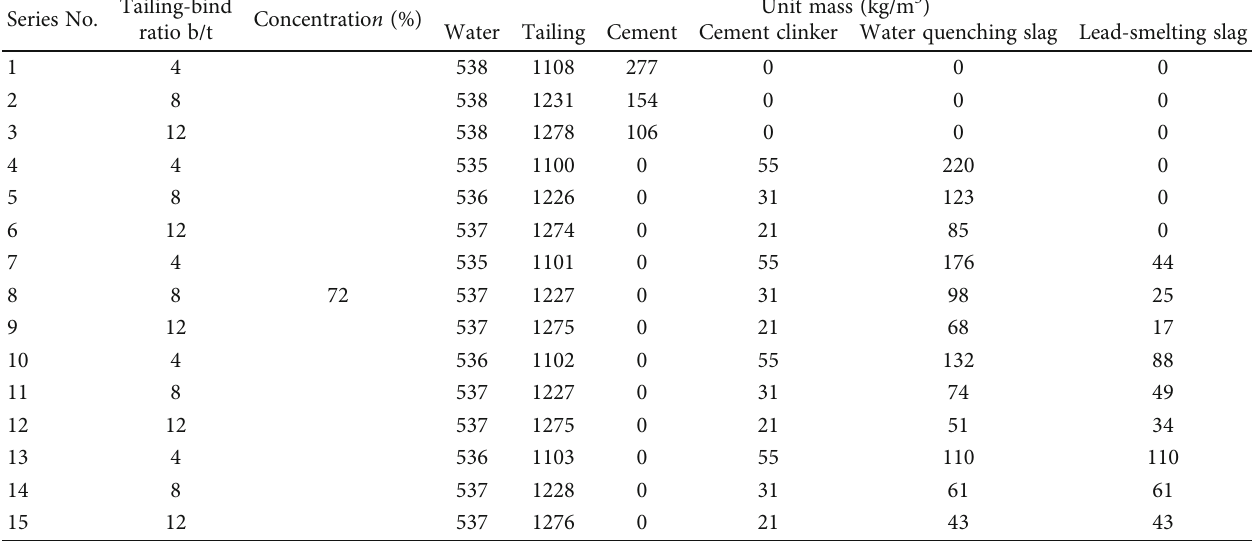
Table 4: Proportion.